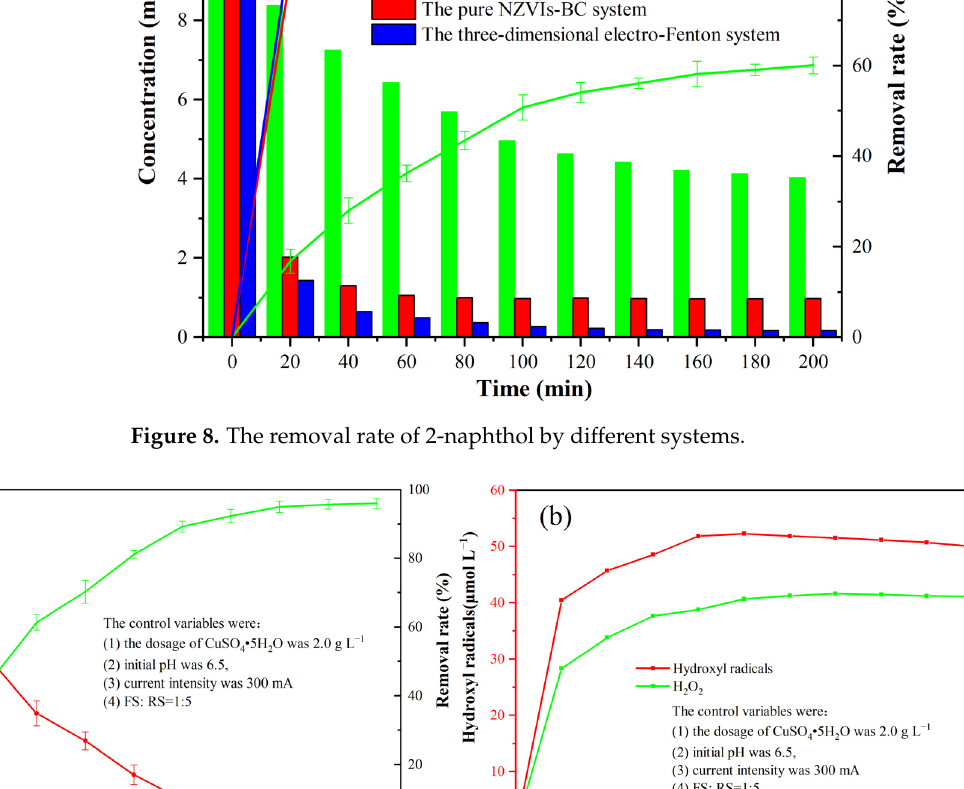
Figure 10. The possible degradation pathways of 2-naphthol in aqueous solution. Based on the UPLC-MS-Q-O test and changes in the products’ functional groups, the main chemical reactions involved in the above conversion were: Ⅰ — desaturation, Ⅱ — carbonylation, Ⅲ — hydration, Ⅳ — reduction, Ⅴ — acetylation, Ⅵ — deacylation, and Ⅶ — substitution. According to the “Globally Harmonized System of Classification and Labelling of Chemicals (GHS)” and the ECOSAR system, the toxicity of 2-naphthol and its degrada- tion products is studied by the lethal concentration (LC50), concentration of 50% of maximal effect (EC50), chronic value (ChV) as toxicity indicators. In addition, the toxicity standards are divided into four categories, which are: very toxic (<1 mg L − 1 ), toxic (1 mg